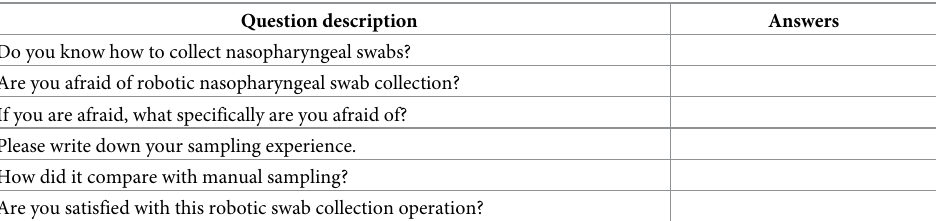
Table 1. Questionnaire in robotic